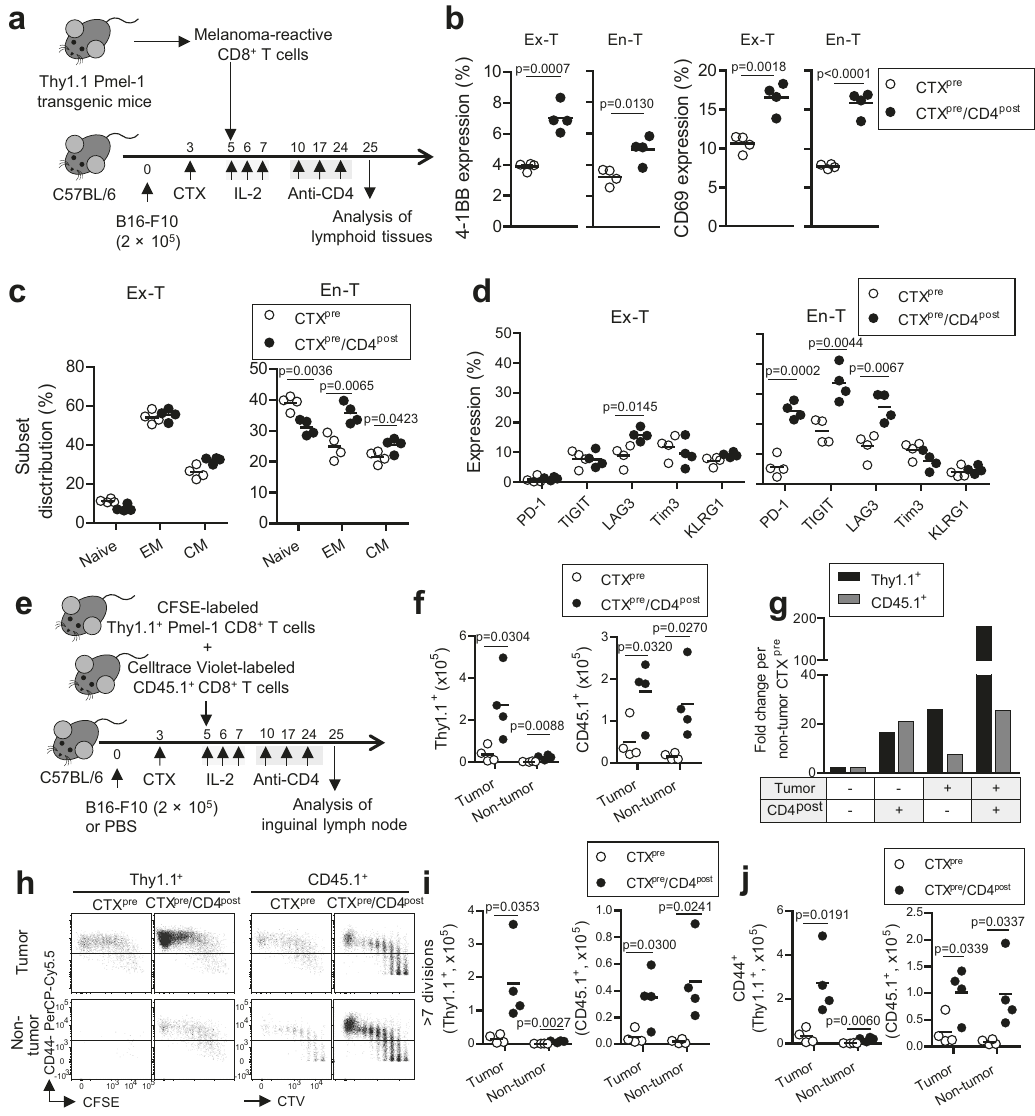
Fig. 2 Anti-CD4 post conditioning accelerates proliferation and differentiation of ex vivo-primed and endogenous CD8 + T cells. a Schematic of the experiment. Injected cell number: B16-F10, 2 × 10 5 /mouse; ex vivo-primed Thy1.1 + Pmel-1 CD8 + T (ex-T) cells, 2 × 10 6 /mouse. b – d Marker expression and subset analysis of ex-T and endogenous CD8 + T (en-T) cells. c The proportion of naive (CD62L + CD44 − ), EM (effector memory; CD62L − CD44 + ), and CM (central memory; CD62L + CD44 + ) subsets were calculated. e – j Analysis of the proliferation of ex vivo-primed Thy1.1 Pmel-1 CD8 + T (Thy1.1 + ) cells and unstimulated polyclonal CD8 + T (CD45.1 + ) cells in the presence or absence of tumor antigen. e Schematic of the experiment. Injected cell number: B16-F10, 2 × 10 5 /mouse; Thy1.1 + , 1 × 10 6 /mouse; CD45.1 + , 1 × 10 6 /mouse. f The cell count of Thy1.1 + and CD45.1 + cells. g Fold change in cell number over the average of the non-tumor CTX pre group. h Representative fl ow cytometry images of Thy1.1 + and CD45.1 + cells analyzed for CD44 expression. The number of cells with more than seven divisions ( i ) and of CD44 expression ( j ) were calculated. n = 4 mice per group. Each symbol indicates the calculated value of an individual mouse. Horizontal bars indicate means. Two-tailed unpaired Student ’ s t -test. CD4 post , anti-CD4 post conditioning; CFSE, carboxy fl uorescein succinimidyl ester; CTV, Celltrace Violet; CTX pre , cyclophosphamide preconditioning; PBS, phosphate-buffered saline. Source data are provided as a Source Data fi Next, we analyzed the intratumoral CD8 + T cells in mice that exposed en-T cells was higher than that of CTX pre -exposed en-T cells (Fig. 3d). Biased T-cell activation alters the TCR repertoire, were inoculated with high dose of B16-F10 to establish measurable which promotes clonal expansion and enrichment of certain TCR tumor volume in both CTX pre and CTX pre /CD4 post groups (Fig. 3f). As expected from the effect of CTX pre /CD4 post on T-cell clonotypes 19 – 21 . Therefore, we analyzed the Shannon evenness of the TCR repertoire, which denotes the extent of equal distribution expansion and tumor reactivity (Figs. 2f, g and 3c – e), CTX pre / CD4 post increased intratumoral in fi ltration of ex-T and en-T cells of the clonotypes, with lower values indicating that some T-cell clones proliferated preferentially 21 . The CTX pre /CD4 post group (Fig. 3g). Phenotypic analysis showed that CTX pre /CD4 post - had signi fi cantly lower evenness than the CTX pre group (Fig. 3e; experienced en-T cells were more differentiated and included higher proportion of PD-1 + cells than the CTX pre -exposed group p = 0.03 for TCR α and TCR β ; Mann – Whitney U -test), indicating (Fig. 3h, i and Supplementary Fig. 2f, g). Highly tumor-reactive the enrichment of certain T-cell clonotypes.